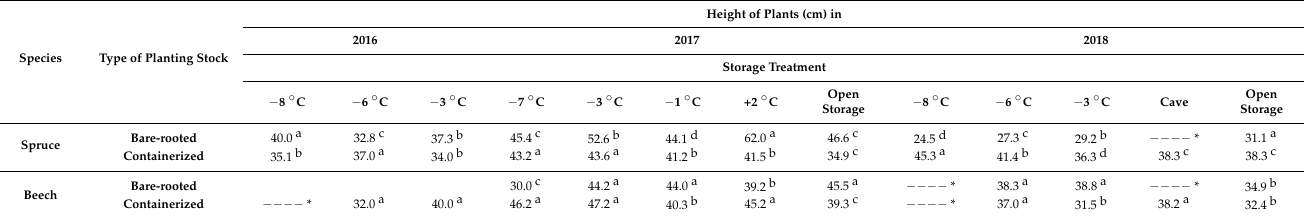
Table 3. Average height of Norway spruce and European beech in storage treatments at the end of the first growing season in three years of the research (different letters in the exponent (a, b, c) denote significant differences between storage treatments within each tree species and type of planting stock in every year of the research).